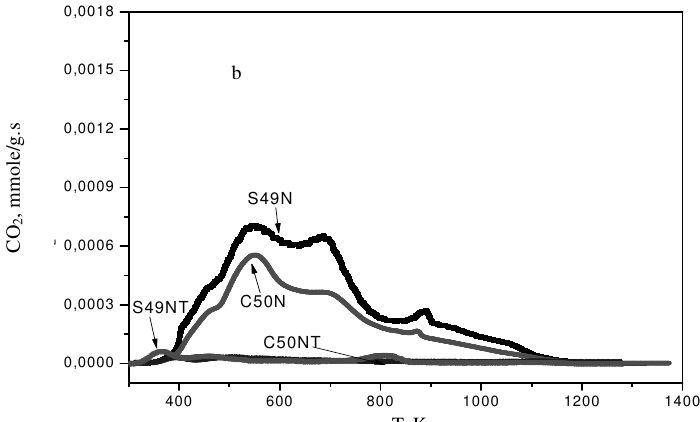
in TPD experiments for oxidized (C50N and 2